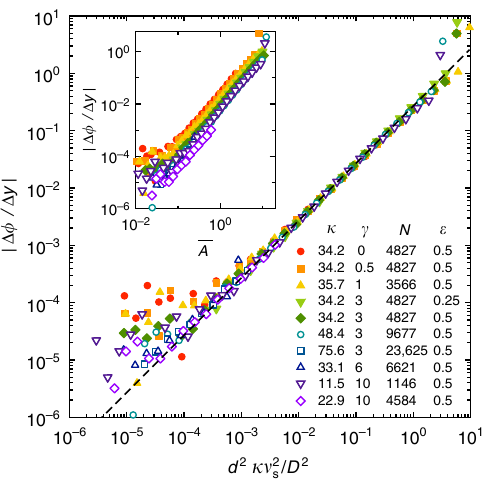
Fig. 5 Steady state vertical concentration gradient. Inset: Δ ϕ = Δ y j j versus A , obtained by averaging over fi ve systems. Main: The data are collapsed = D 2 . Dashed line: Scaling argument with fi tted when plotted versus d 2 κ v 2 s numerical prefactor, Eq.